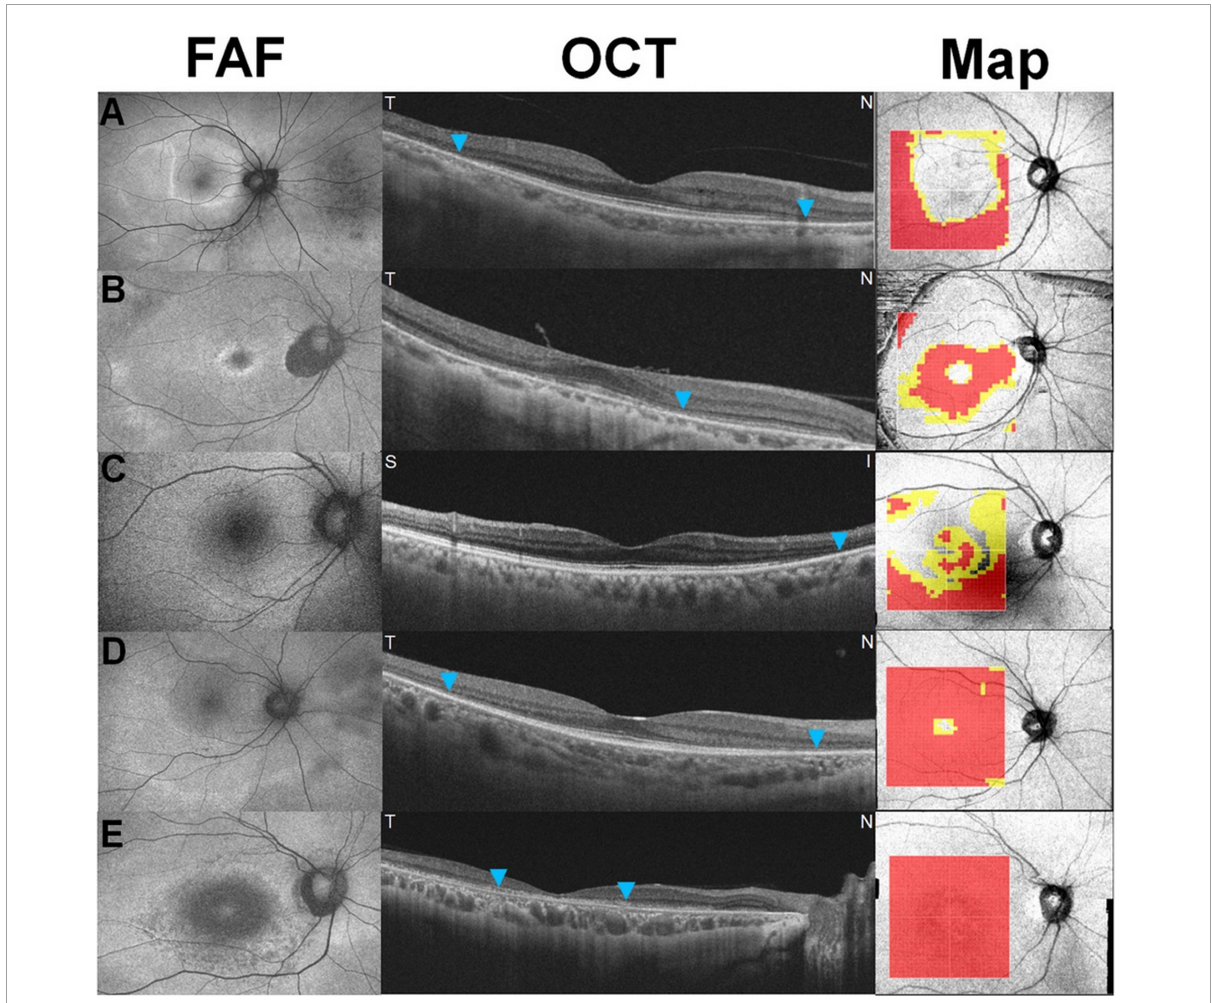
FIGURE3 Five recognizable patterns [a pericentral ring (A) , parafoveal ring (B) , mixed ring (C) , central island (D) , and whole macular thinning (E) ] of retinal thinning in retinal thickness deviation maps on swept-source optical coherence tomography in eyes with hydroxychloroquine retinopathy. Yellow (representing a thickness of < 5% of the normative level) or red pixels (representing a thickness of < 1%) indicate retinal thinning [Reprinted with permission from Kim et al. (11)].